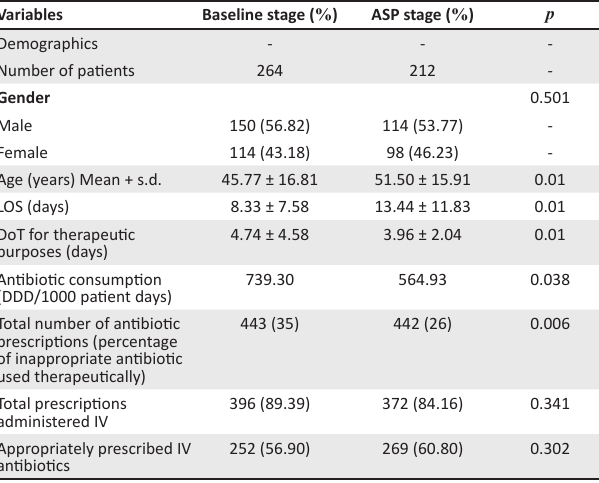
TABLE 2 : Patient demographics and clinical